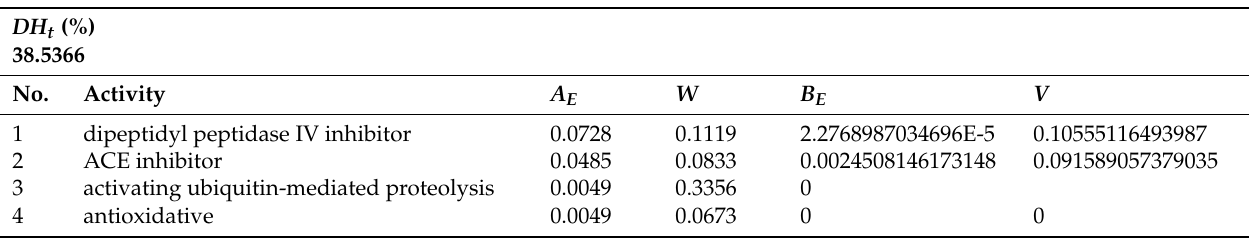
Table A32. A E , DH t , W , B E and V values from RubisCO of Halophila stipulacea . In silico enzymatic cleavage was carried out by using leukocyte elastase.